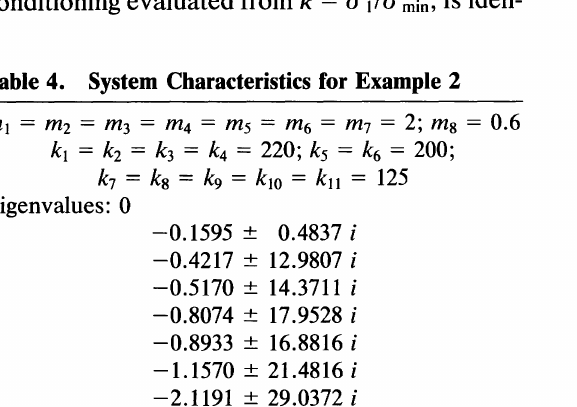
Table 5. Displacement Comparison for Example